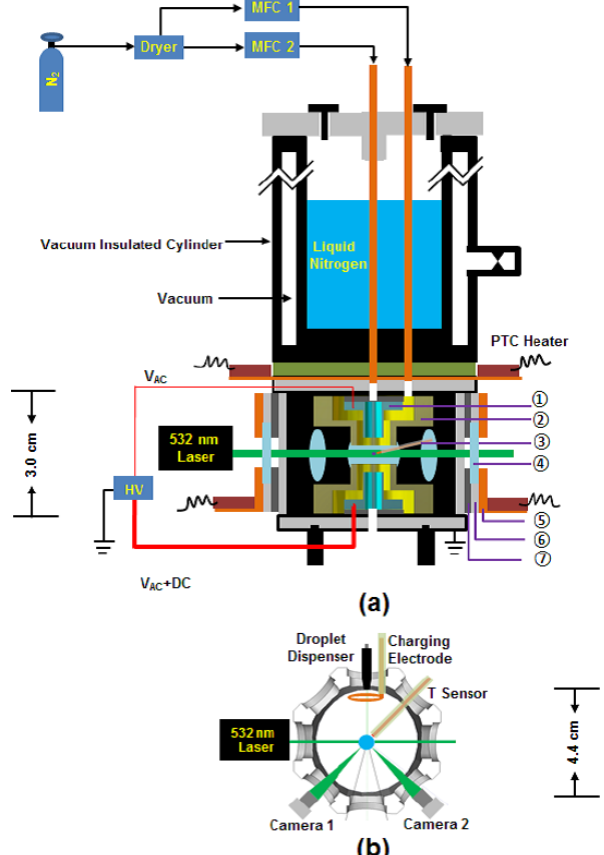
Figure 15. Schematic diagram of a cold electrodynamic balance. (a) Side view of this setup: (1) inner electrode; (2) outer electrode; (3) temperature and RH sensors; (4) glass optical window; (5) heat- ing jacket; (6) optical window holder; (7) rubber insulator. (b) Top view of this setup: droplets were generated using a droplet dispenser and charged using a charging electrode, and one of them may be trapped at the null point. A 532nm laser was used to illuminate the trapped particle, and two cameras were used to observe the particle and record the scattered light. Reprint with permission by Tong et al.